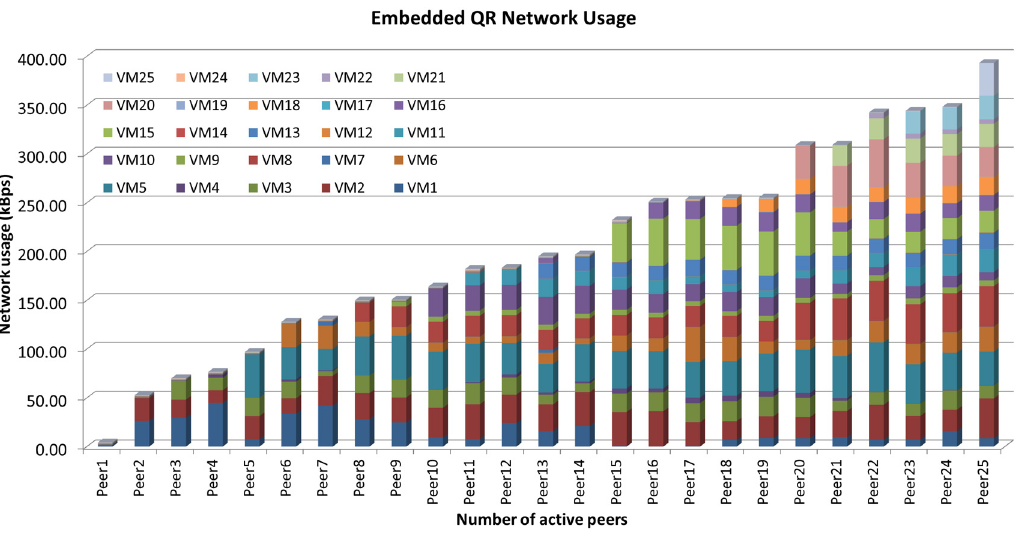
Figure 16. Network usage (in Kbps) per peer on a network of N = 25 peers.